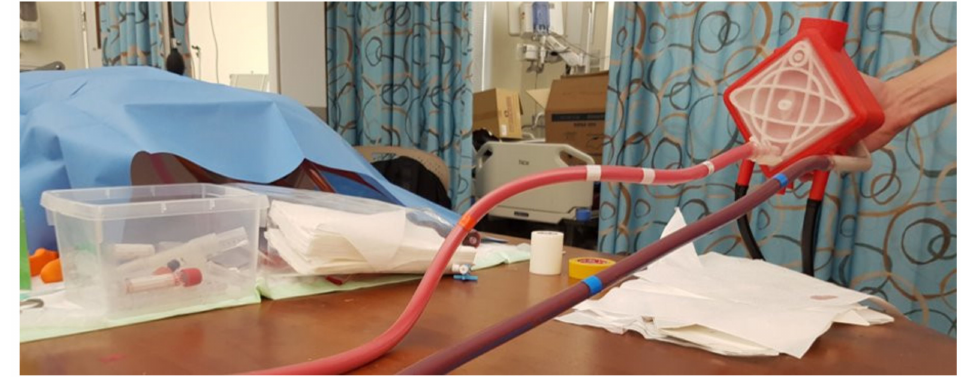
Figure 19. ECMO machine simulator